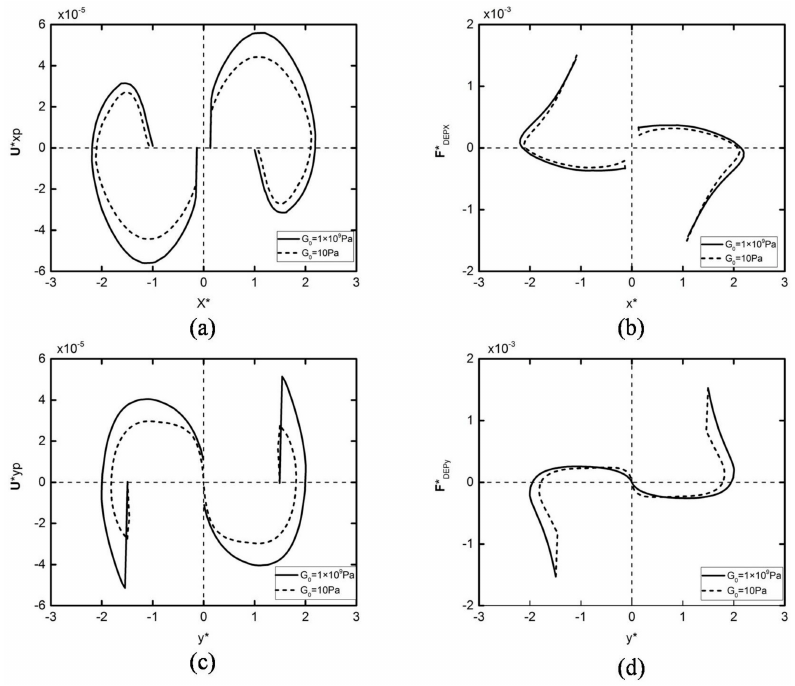
Figure 9. The x , y -component velocity ( a , c ) and x , y -component DEP particle–particle interaction force ( b , d ) variations of the two particles initially located with θ = 85 ◦ and R * = 3 subjected to an external electric field E ∗ = 0.05. The solid lines and dashed lines represent G 0 = 1 × 10 9 Pa and G 0 = 10 Pa,